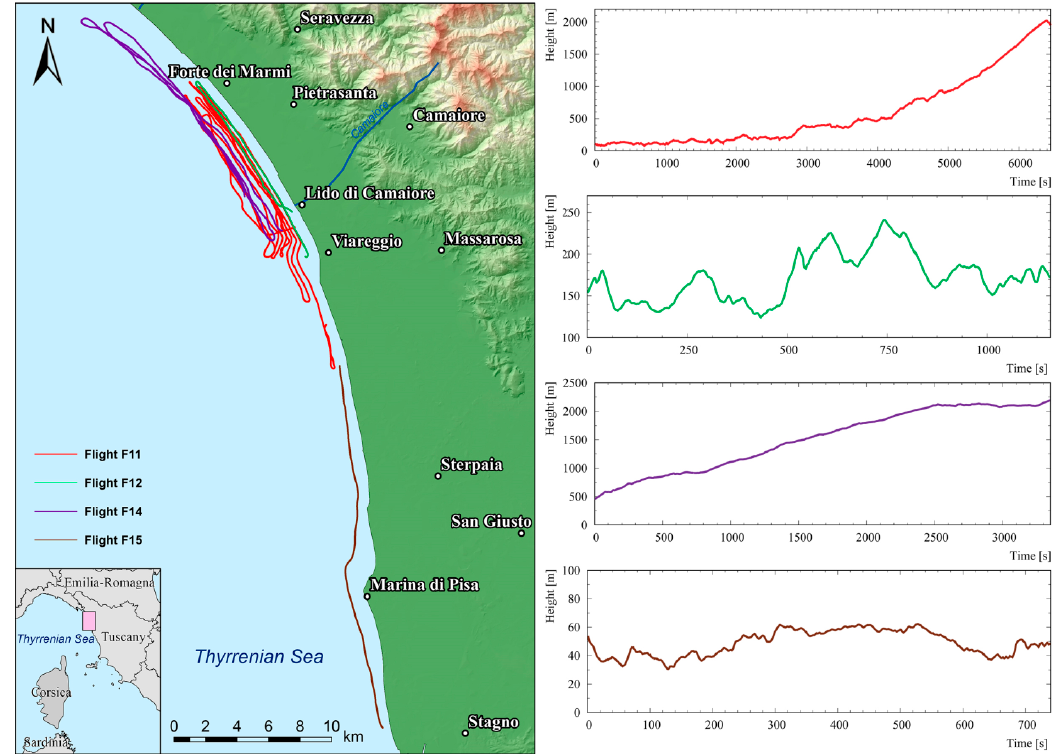
Figure 1. The left panel shows a map of the paths flown during the four surveys over the sea between Forte dei Marmi (LU) and Marina di Pisa (PI) in Italy. The four panels on the right show the mean altitude profiles measured by GPSABC of each flight.